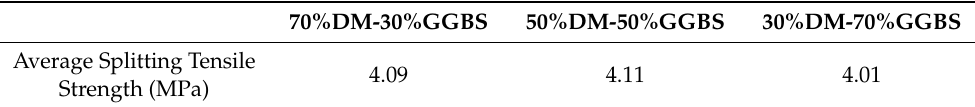
Table 4. Average Splitting Tensile strength per